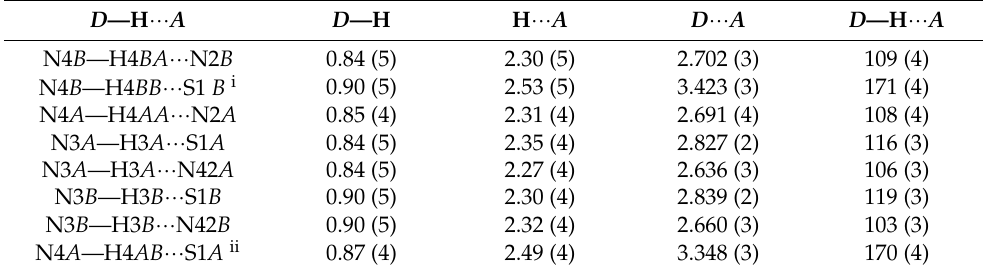
Table 4. Hydrogen-bond geometry (Å, ◦ ) for compound 2